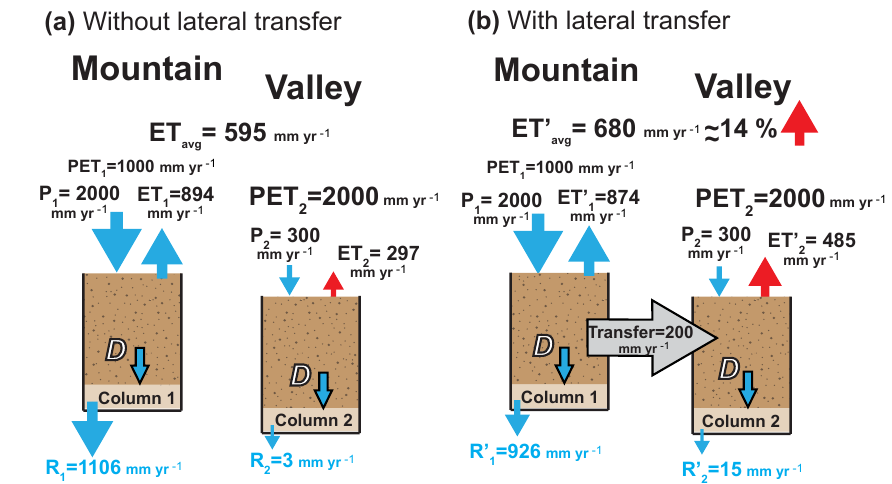
Figure 8. Hypothetical numerical experiment with conceptual two-column model: (a) no lateral transfer between columns, (b) 200mmyr − 1 lateral transfer from Column 1 (mountain) to Column 2 (valley) increases average ET by 14%. The magnitude of P (precipitation), PET (potential evapotranspiration), ET (actual evapotranspiration), and R (recharge) are hypothetical and D is drainage to deep groundwater or streamflow.